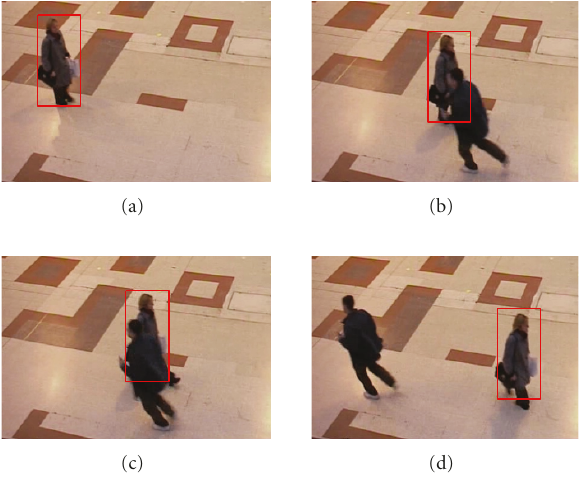
Figure 16: (a) Reference frame (Frame #2246), (b) Frame #2269, (c) Frame #2271, and (d) Frame